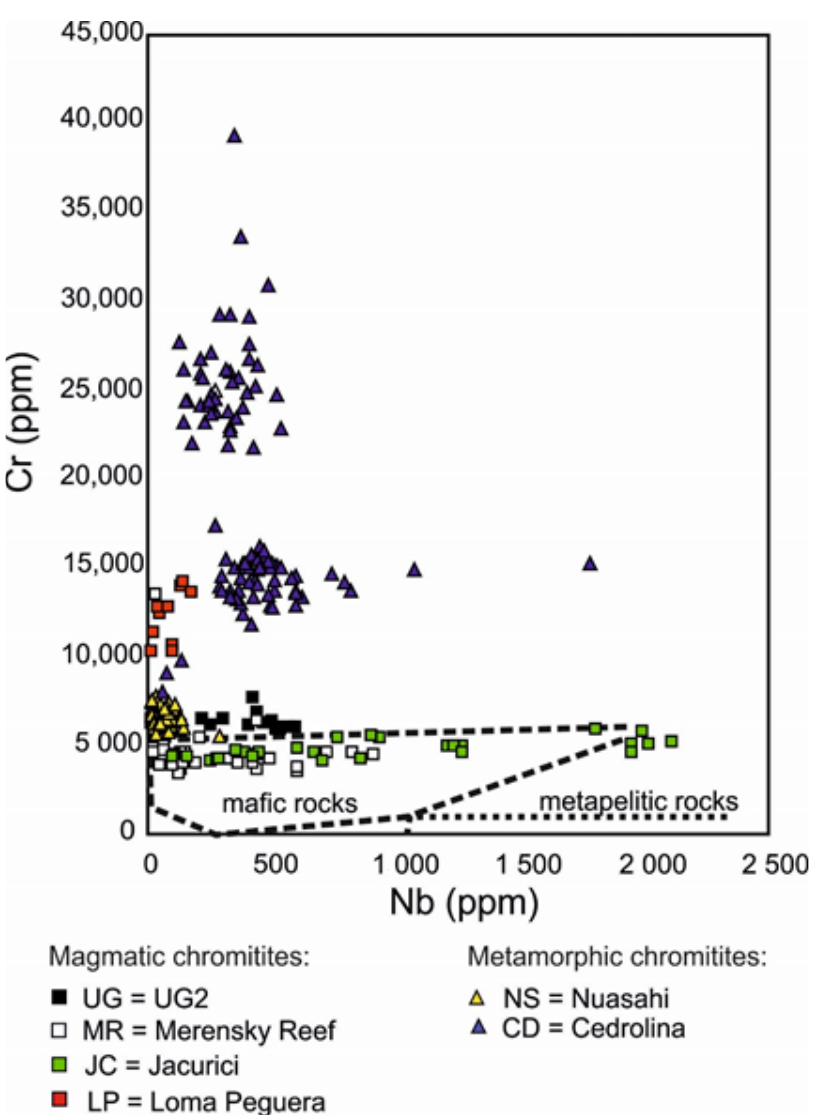
Figure 16. Comparison of Nb/Cr relationships in chromitite-rutile with the field of rutile from mafic and meta-sedimentary rocks which characterize for a consistent Cr depletion (fields redrawn after [7]). Data from the stratiform chromitites of Merensky Reef and Jacurici show a narrow field of overlapping with rutile from mafic